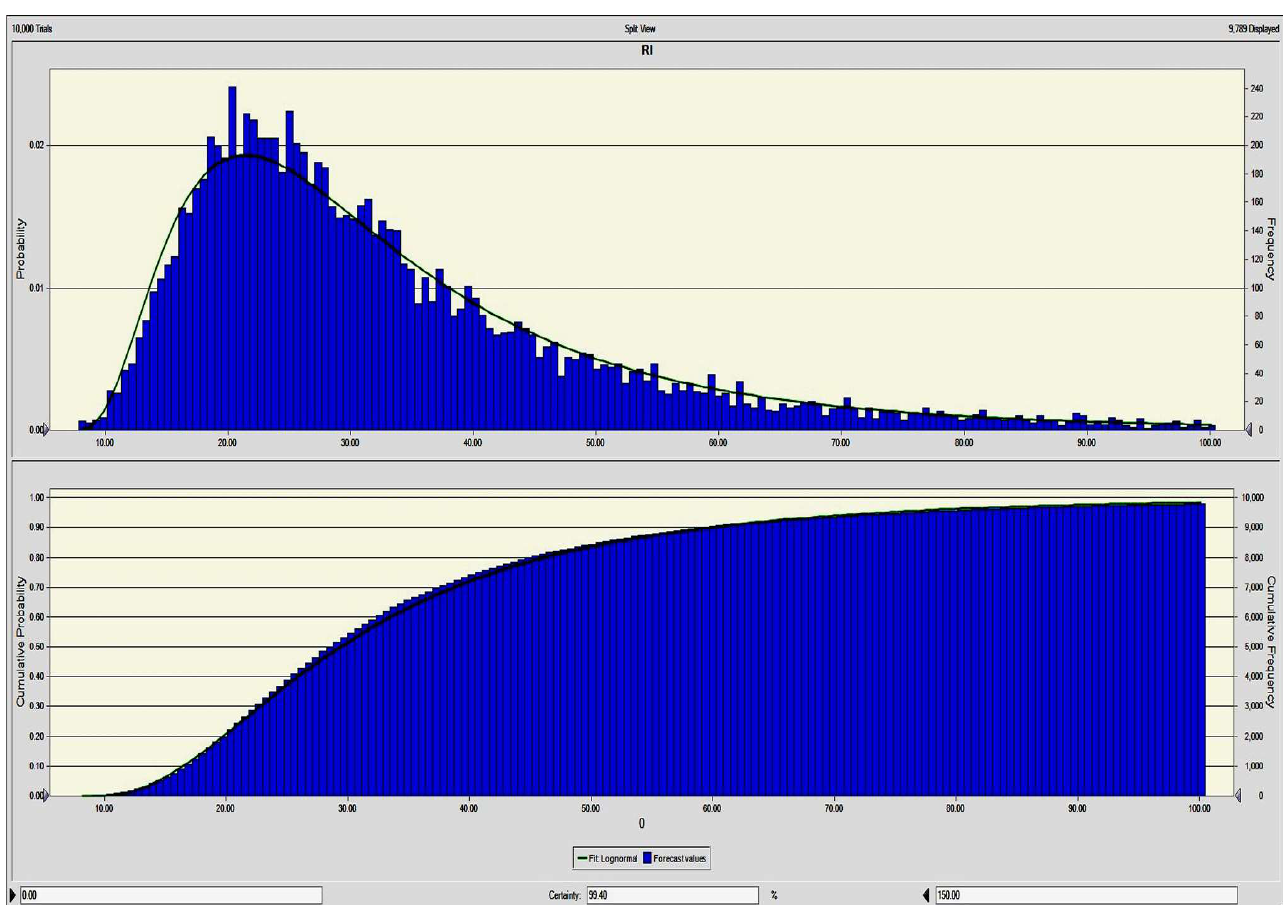
Figure 7. Probability and cumulative probability of Risk Index (RI) Value.